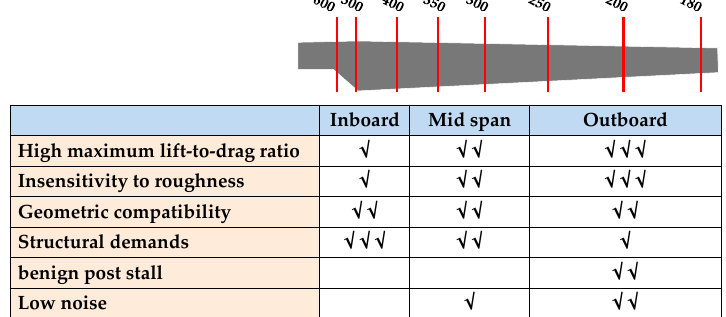
Figure 1. Design goals of NPU-MWA airfoils (created referring to [26], more √ indicates greater importance).